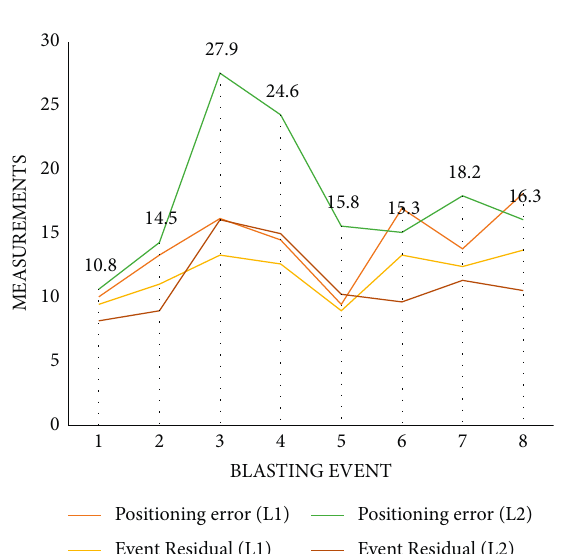
Figure 3: Positioning accuracy comparison results.